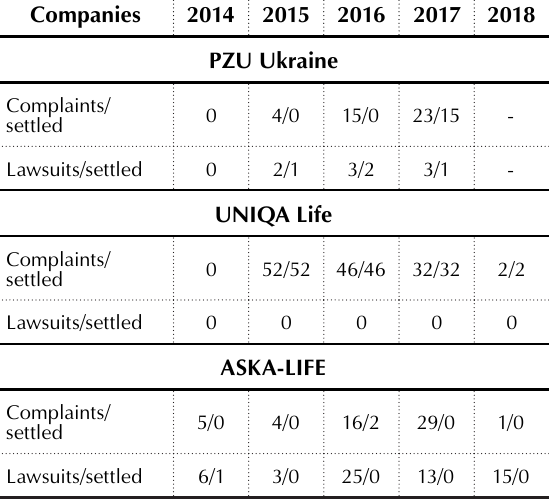
Table 7. Policyholders’ complaints and lawsuits, units